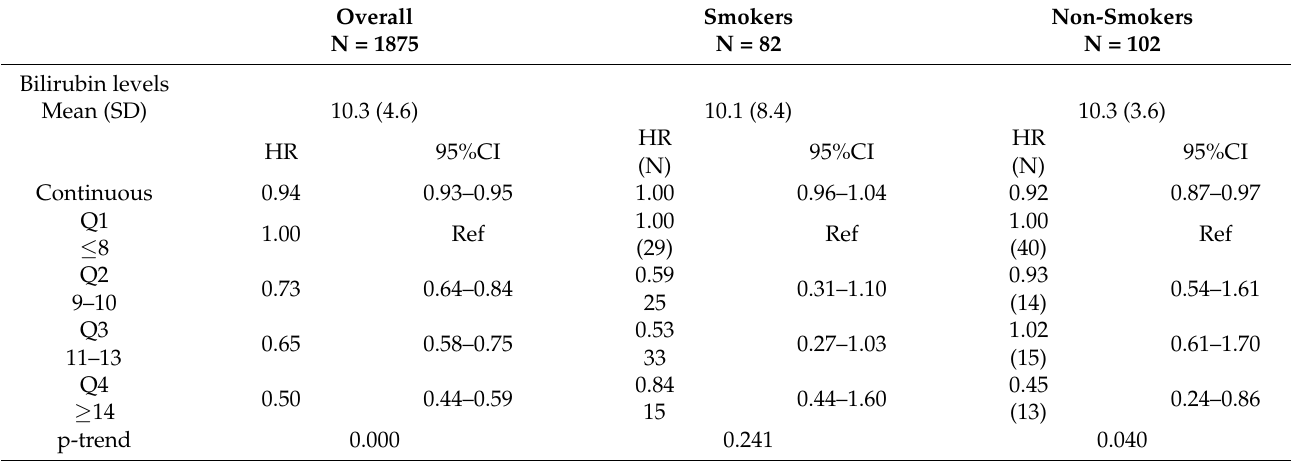
Table 4. Hazard ratios (HR) and 95% confidence intervals (CI) for continuous and quartiles of serum total bilirubin (STB) and lung cancer risk, stratified by smoking